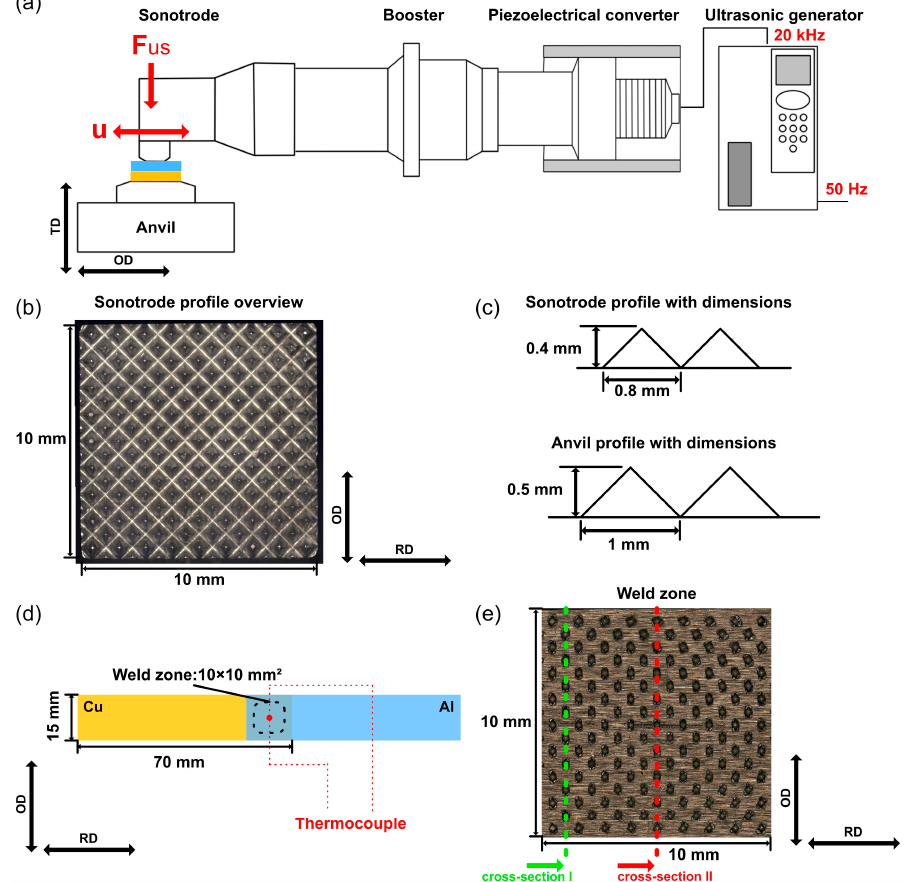
Figure 1. Experimental setup: ( a ) schematic of an ultrasonic welding system, ( b ) optical micrographs of sonotrode profile, ( c ) dimensions of sonotrode and anvil profiles, ( d ) configuration of the joining partners, and ( e ) cut positions of cross-sections.